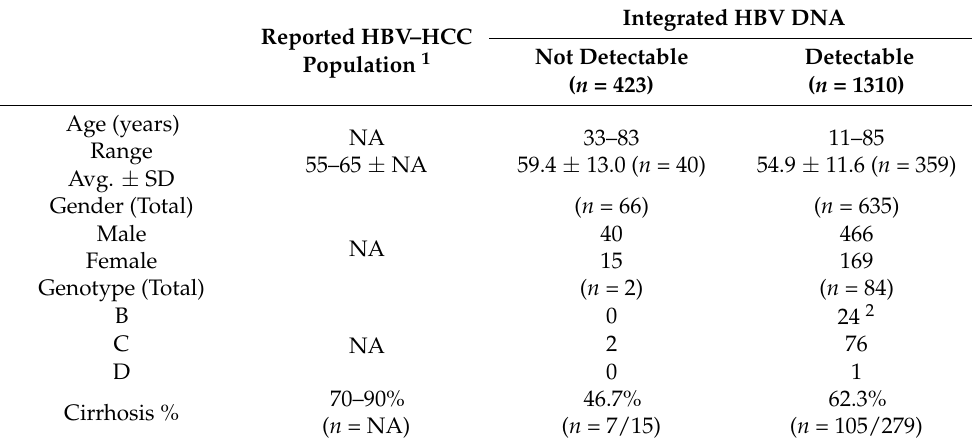
Table 2. Major sociodemographic and clinical features of the study subjects with and without detectable integrated HBV DNA in tumor